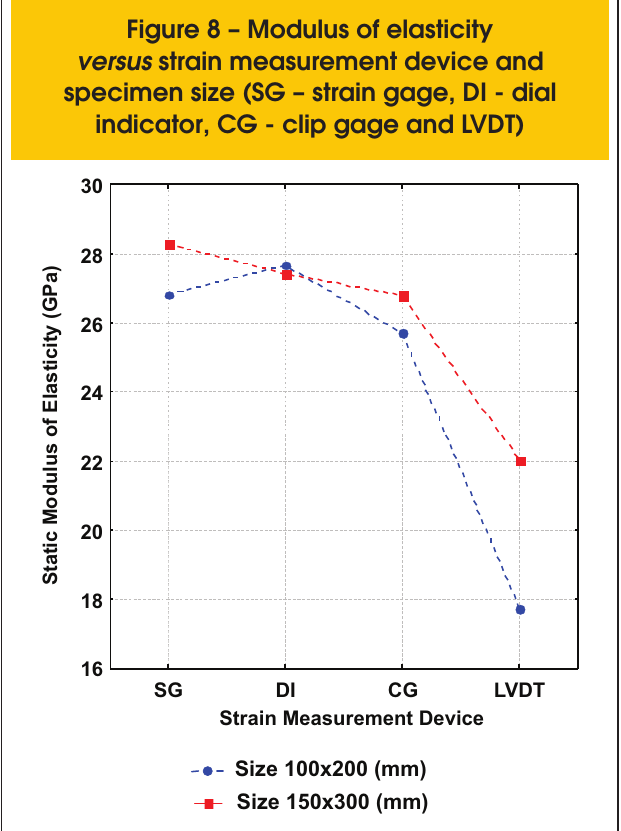
Figure 8 – Modulus of elasticity versus strain measurement device and specimen size (SG – strain gage, DI - dial indicator, CG - clip gage and